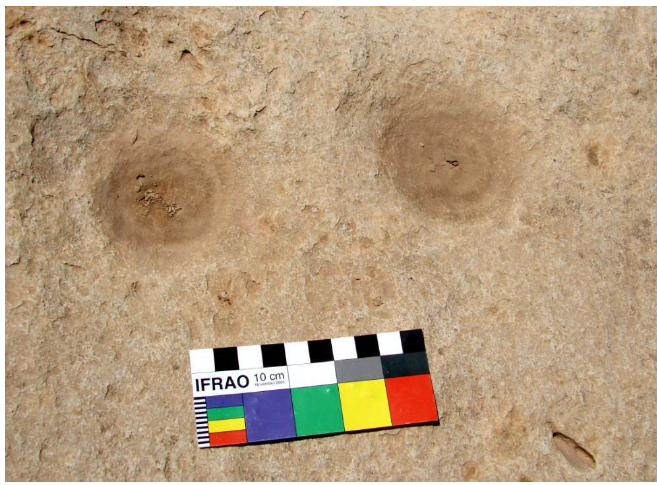
Figure 12. On the horizontal surface of a piece of huge stone, two cupules. On the vertical surface of the rocks that make up the small sanctuary, rock art faces west. There is another panel, which shows two or three anthropomorphs and zoomorphs. The first anthropomorph on